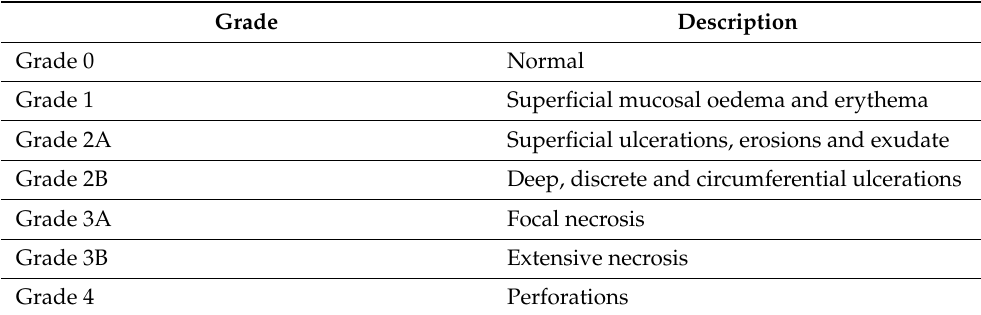
Table 1. Zargar endoscopic classification of upper gastrointestinal injuries secondary to corrosive